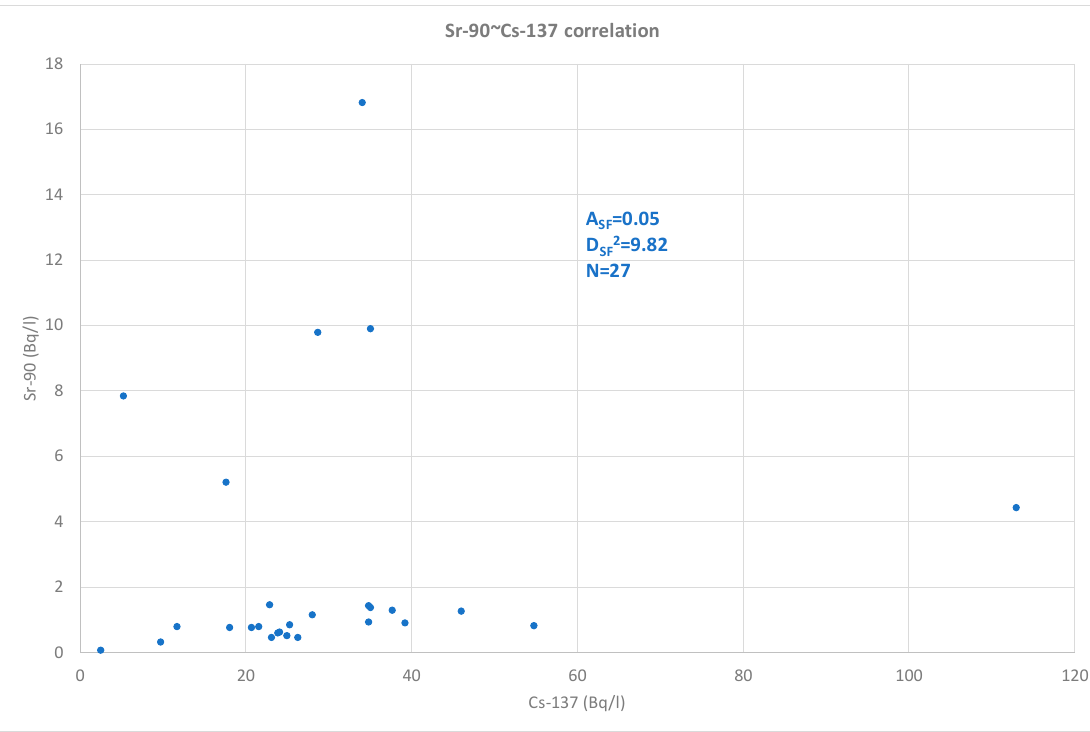
Figure 4. Sr-90~Cs-137 correlation in the Trino “E. Fermi” nuclear power plant’s liquid effluents.